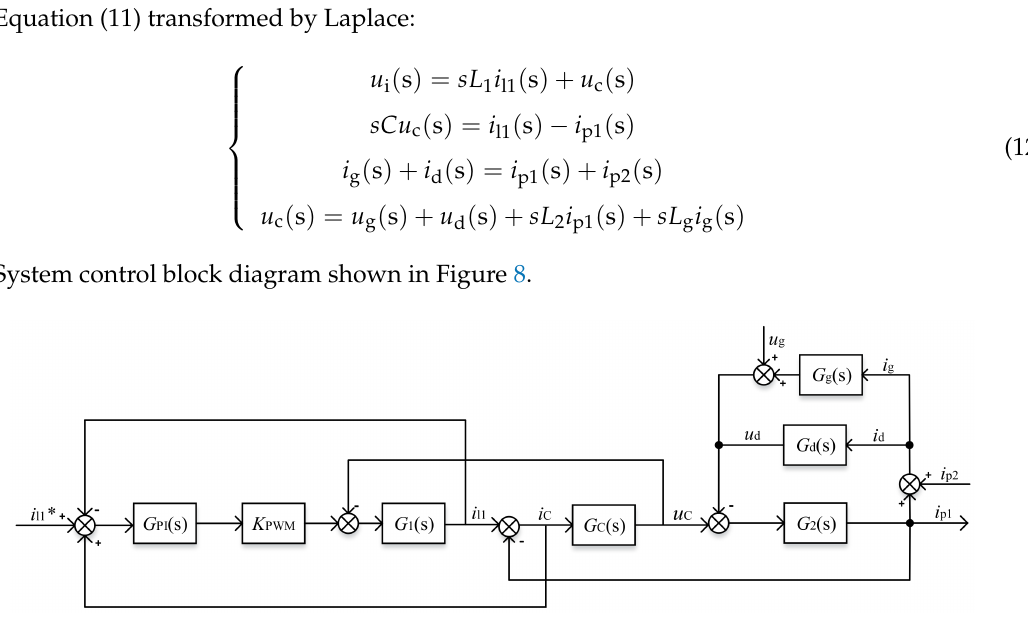
Figure 8. RC resonance suppression circuit block diagram.